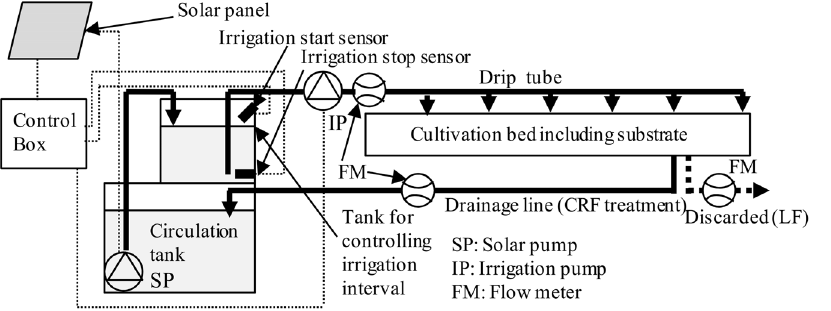
Figure 1. Diagram of the soilless culturing system used in this study. Irrigation starts when the level of nutrient solution reaches the irrigation start sensor in the tank, which controls the irrigation interval, by operating the solar pump. Irrigation stops when the level of nutrient solution decreases to the level of the irrigation stop sensor. The cycle repeats as necessary. Since the flow rate of the solar pump depends on solar power, so does irrigation frequency. column AS12A (4 mm) with guard column AG12A (4 mm); a solution with 2.7 mM Na 2 CO 3 and 0.3 mM NaHCO 3 as eluent; 1.2 mL ? min 2 1 eluent flow rate; injection volume of 0.1 mL. The